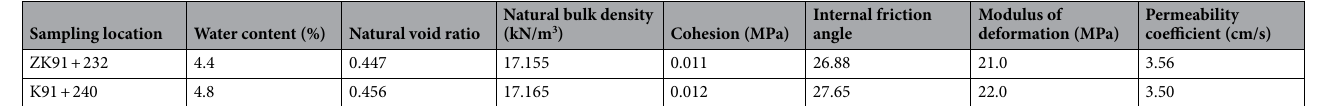
Natural bulk density (kN/m 3 )